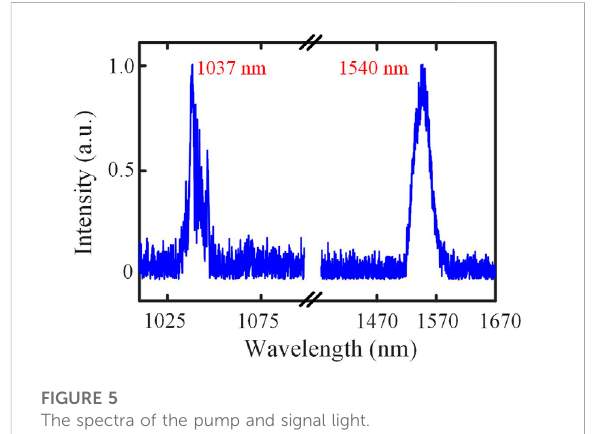
FIGURE 5 The spectra of the pump and signal